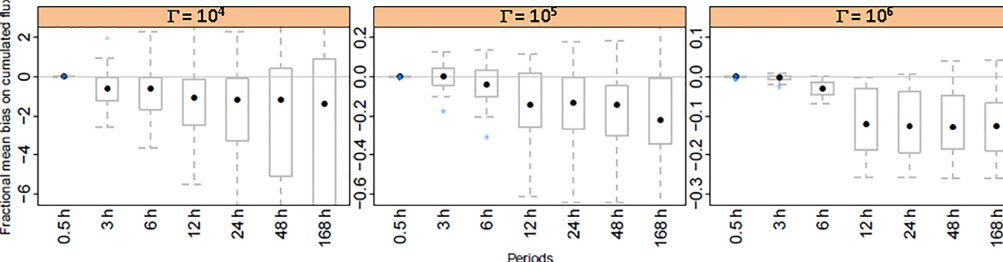
Figure 9. Effect of integration period on source inference in a multiple-plot set-up. The fractional mean bias of the source is shown for each treatment. Inference strategy C1 was used (single sensor, independent blocks, background concentration known). Statistics for runs with target heights 0.25 and 0.5m and a source width = 25m are calculated. All application periods are considered. Filled points show medians, boxes show interquartiles, and bars show minimums and maximums. Outliers are points up to 1.5 times away from box limits.